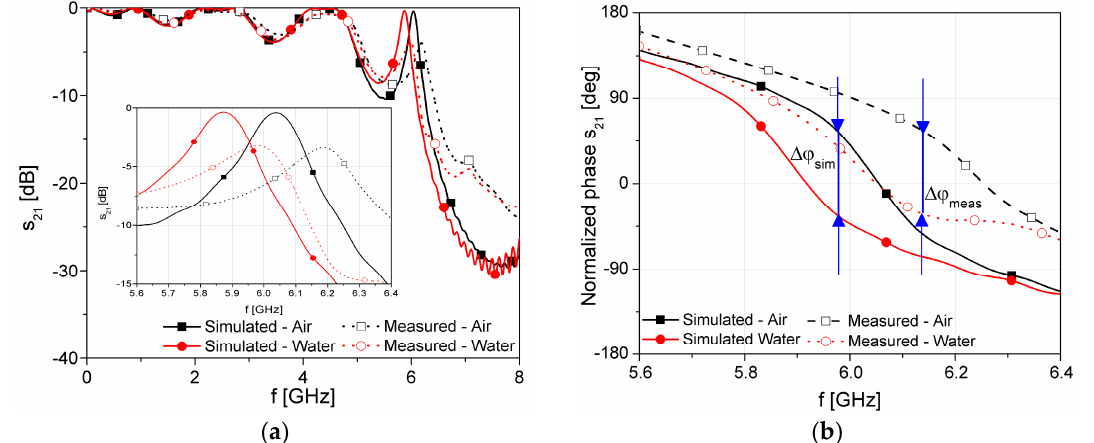
Figure. 9. Comparison of the measured and simulated responses: ( a ) Transmission characteristic; and ( b ) Normalized phase.